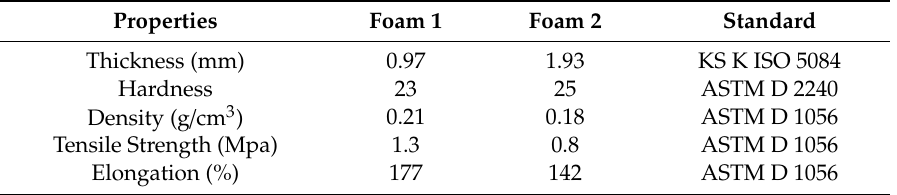
Table 5. Properties of CR